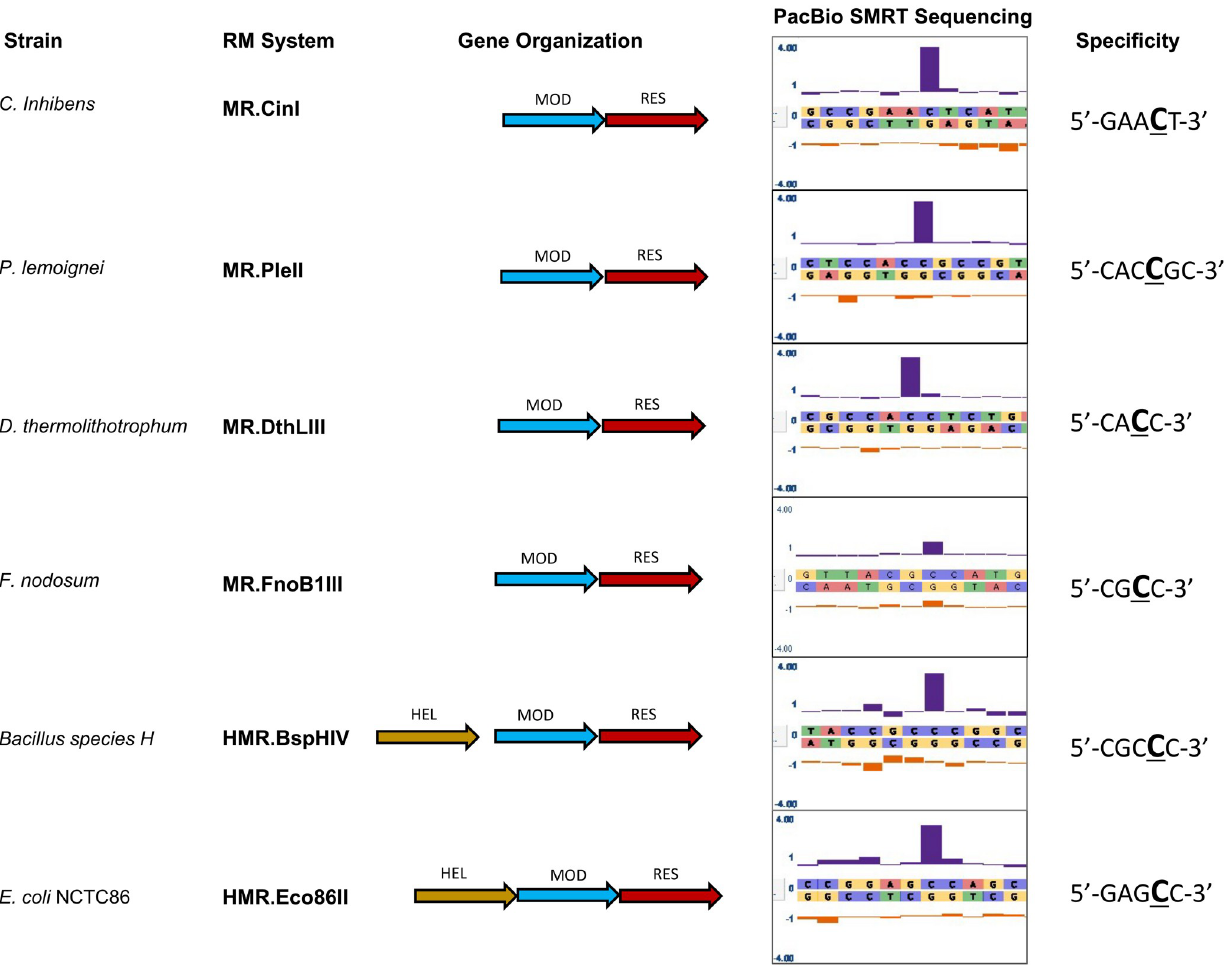
Fig 1. Identification of six Type III restriction-modification (RM) systems that methylate the N4 atoms of deoxycytosine bases. Four systems share a common architecture with previously-identified Type III systems comprised of Res and Mod subunits, whereas two additional systems appear to encode a third protein subunit located 5’ of their respective mod genes. Note that in the case of the BspHIV system there is approximately 140bp of non-coding sequence between the 3’-end of the helicase-like ATPase subunit and the 5’-end of the mod gene. SMRT-sequencing was employed to identify derived consensus methylation motifs for each of the six Type III RM systems. The tall blue bars indicate the Inter-Pulse Duration (IPD) values associated with positions of N4C methylation.